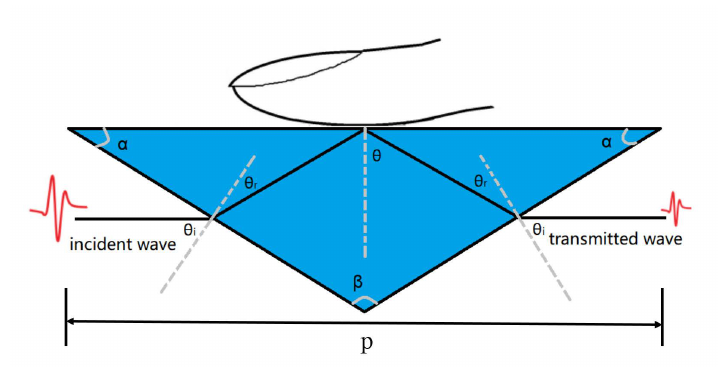
Figure 1. Schematic diagram of the prism ( n prism = 3.42): the bottom length P = 6.2 cm, the top angle β = 104 ◦ , the bottom angle α = 38 ◦ , angle from the perpendicular line θ = 51.6 ◦ , contacting angle between prism and sample θ i = 52 ◦ , entering the prism refraction angle θ r = 13.3 ◦